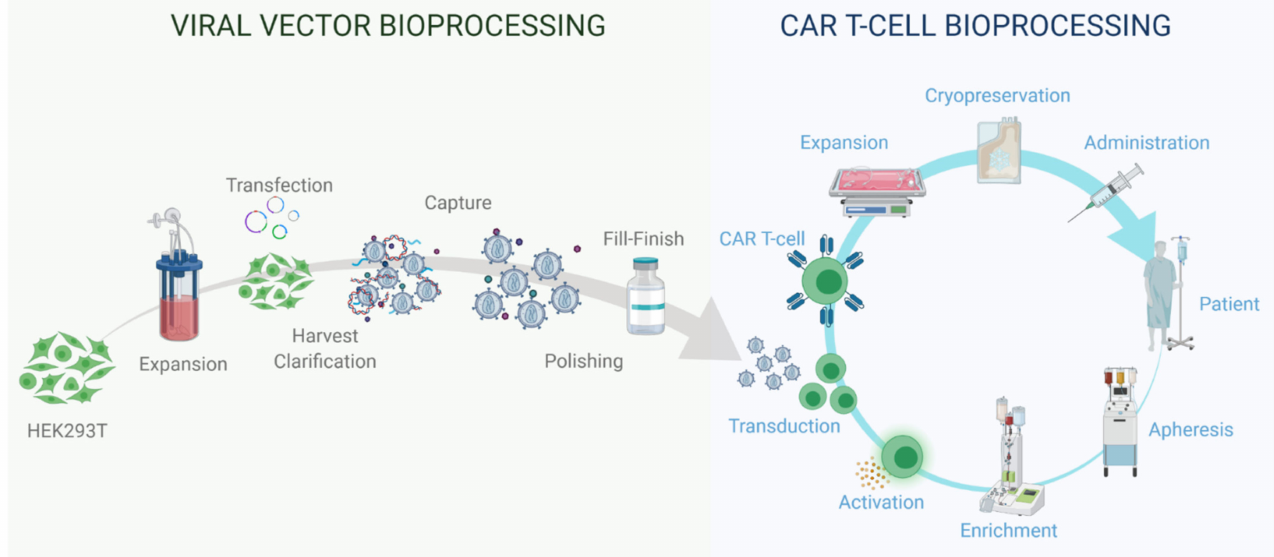
Figure 3. Viral vector and autologous CAR T cell therapy